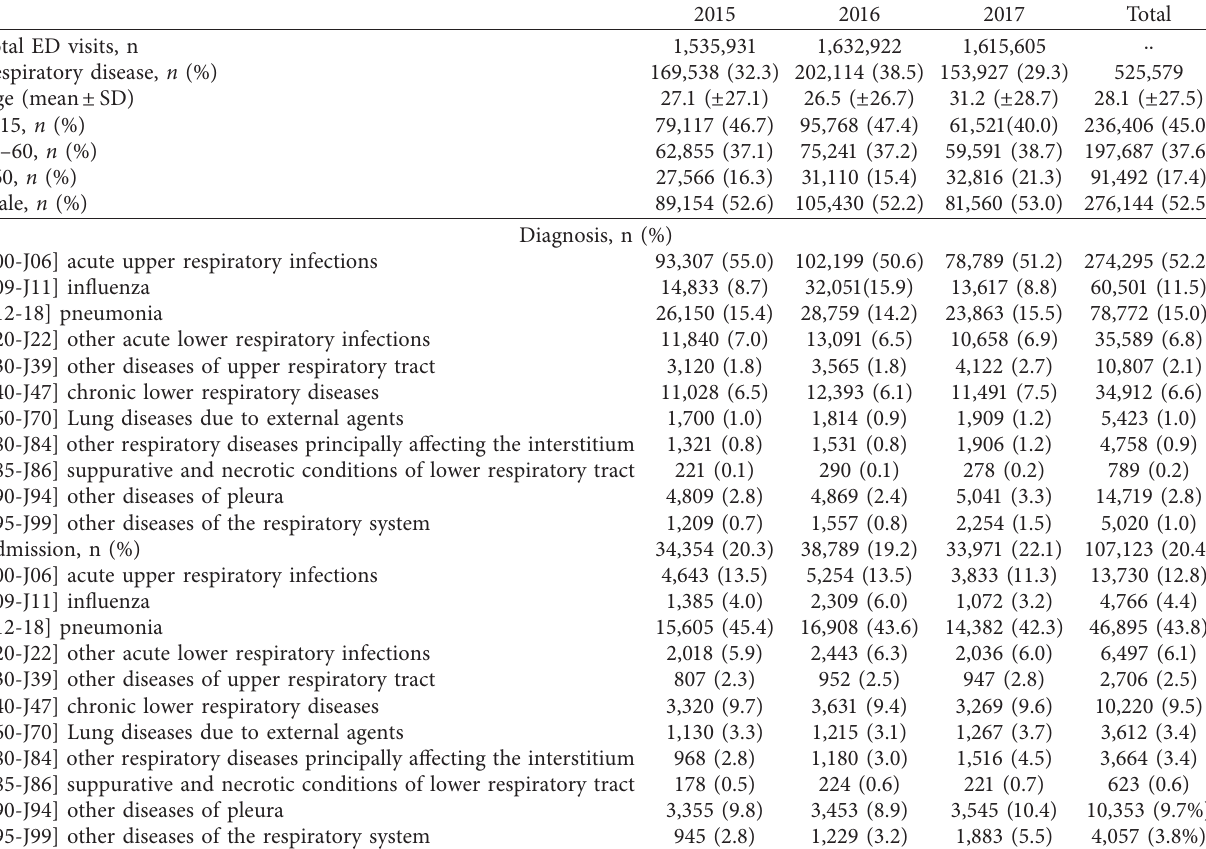
Table 1: General